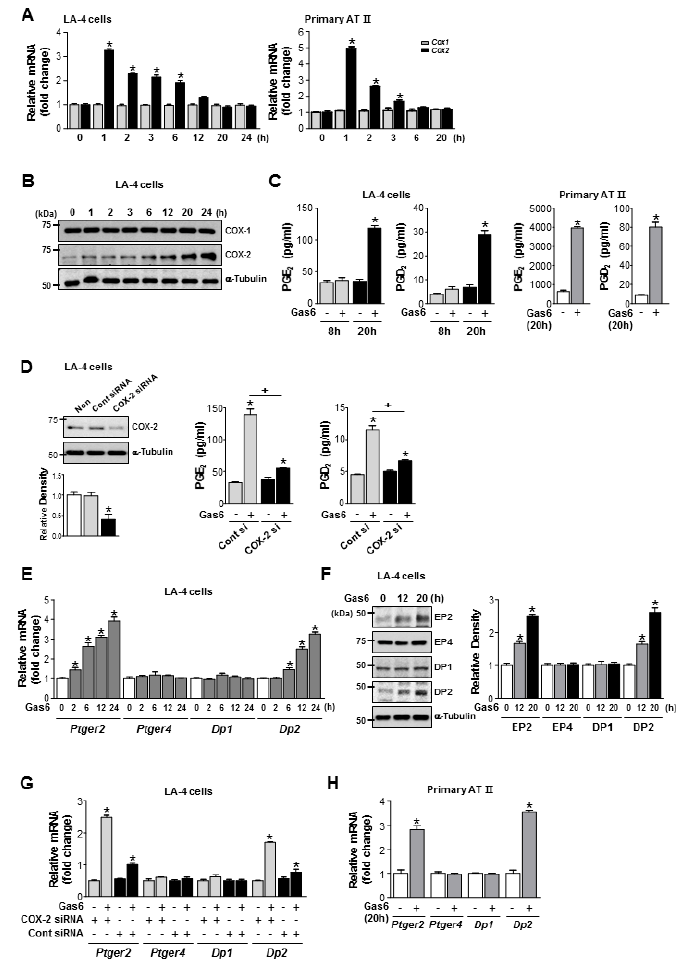
Figure Figure 3. Cyclooxygenase (COX)-2 signaling is required for growth arrest-specific protein 6 (Gas6)- induced production of prostaglandin (PG)E 2 , PGD 2 , and their receptors. ( A to C ) LA-4 and primary alveolar type II (AT II) epithelial cells (ECs) were treated with 400 ng/mL Gas6 for the times indicated.